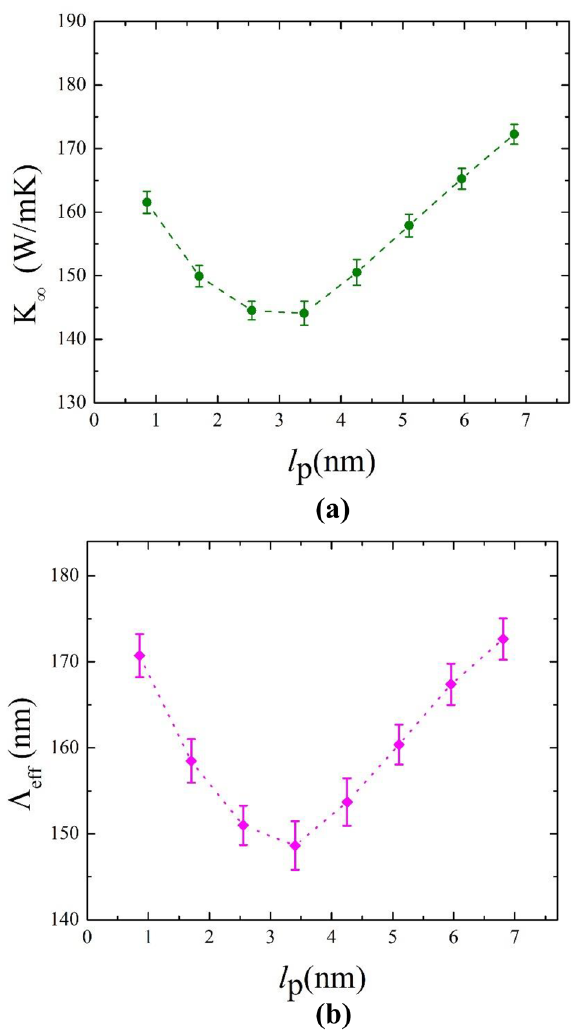
Figure 5. ( a ) Intrinsic thermal conductivity and ( b ) effective phonon MFP as functions of superlattice period for graphene/graphane superlattice nanoribbons at T = 300 K and ΔT = 40